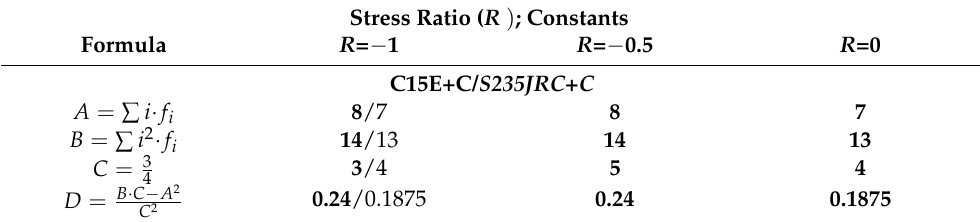
Table 4. A, B, C and D constants, calculated (ISO standard